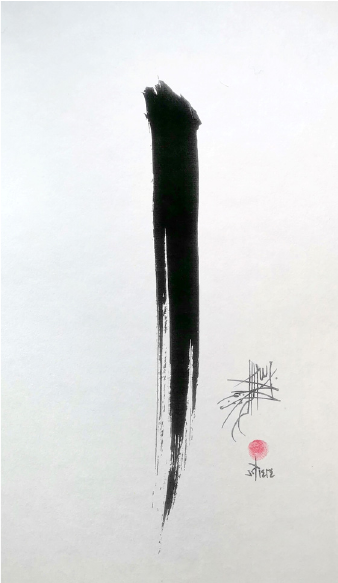
Figure 1. Ahmed Kreusch, Hayy , 1998. Ink on paper. 19 × 24 cm . © Ahmed Kreusch.